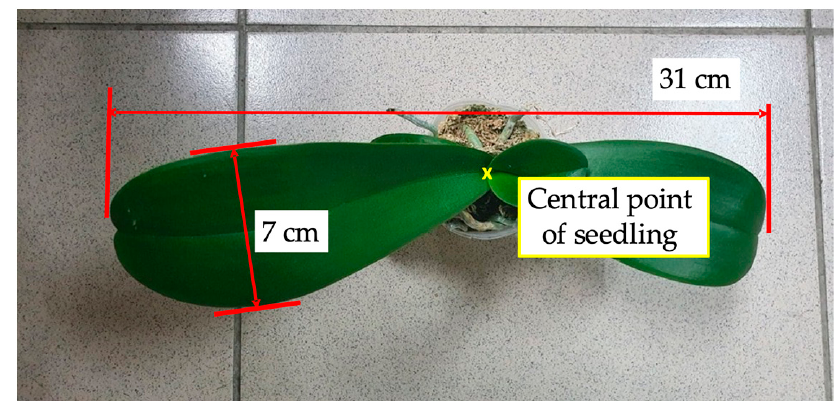
Figure 22. Target of Condition 2.